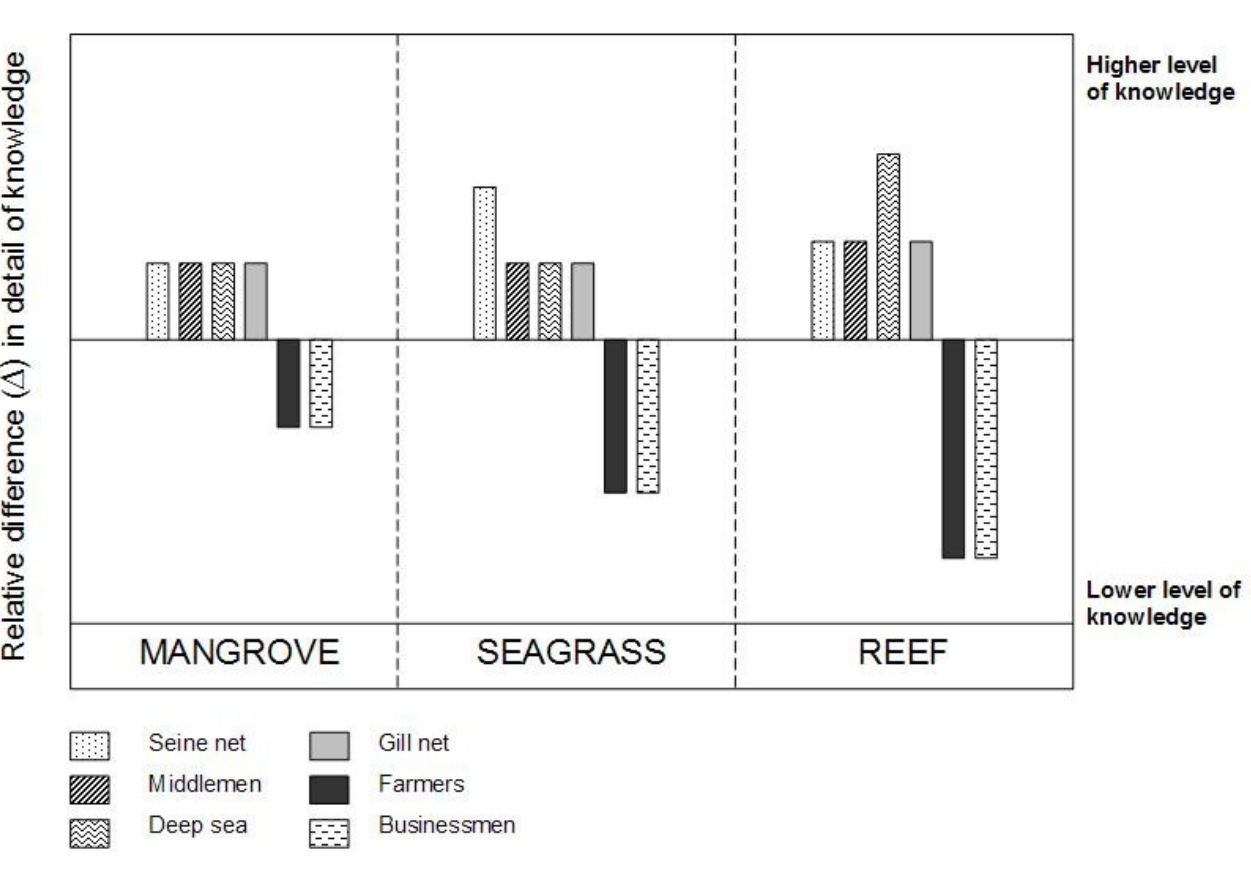
Fig. 6. Relative difference in local ecological knowledge among different occupational groups operating in the target community. Knowledge is divided into three categories based on the three recognized subcomponents of the coastal seascape: mangrove, seagrass, and reef. Knowledge of different groups for each subcomponent is represented as the relative difference of their level of knowledge compared to an estimated average level of knowledge for all groups, i.e., the baseline in the figure. Thus, the bars represent each group’s knowledge in relation to other groups. Amount of knowledge, for each occupational category, is ranked based on the expressed level of detail of ecological components and processes (adapted from Crona